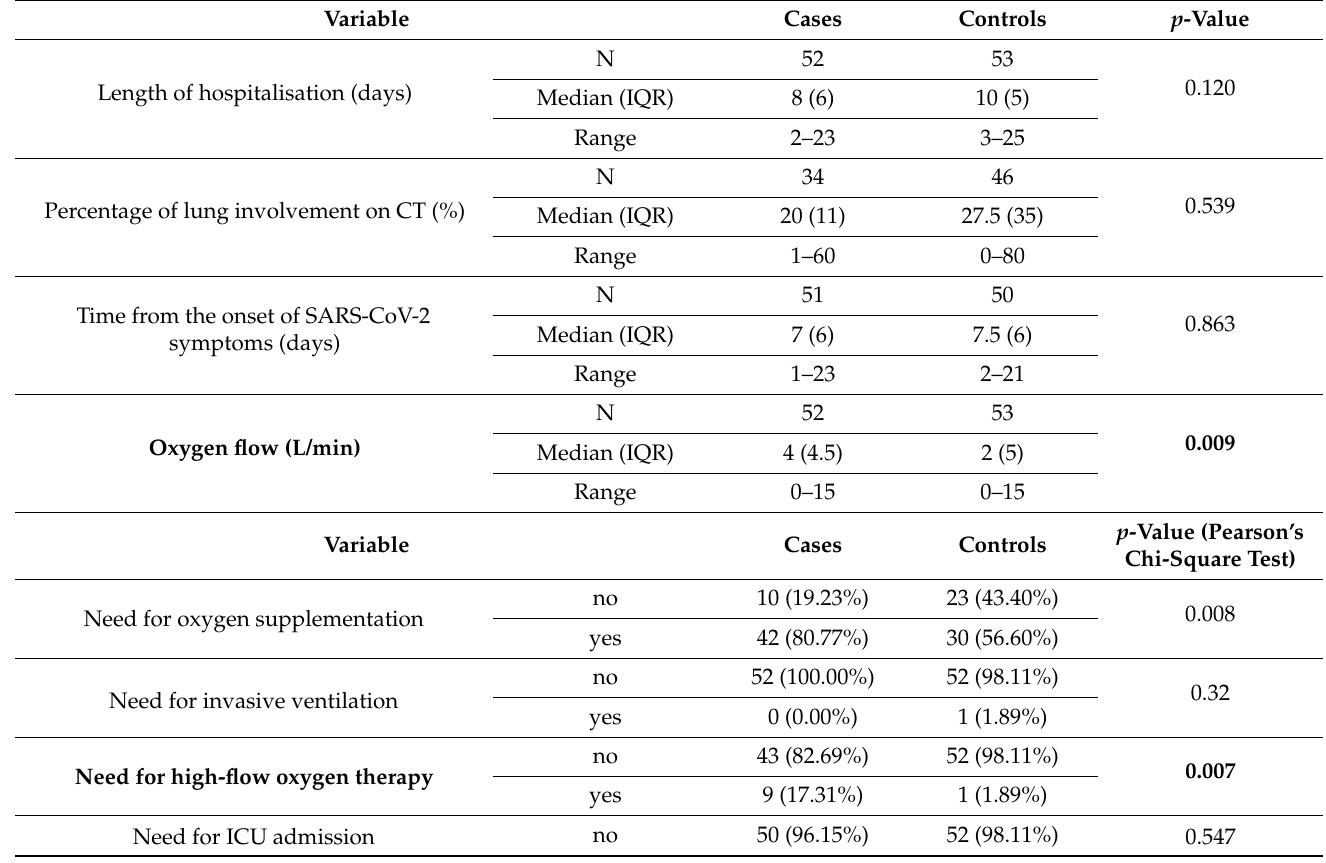
Table 6. Clinical course parameters.